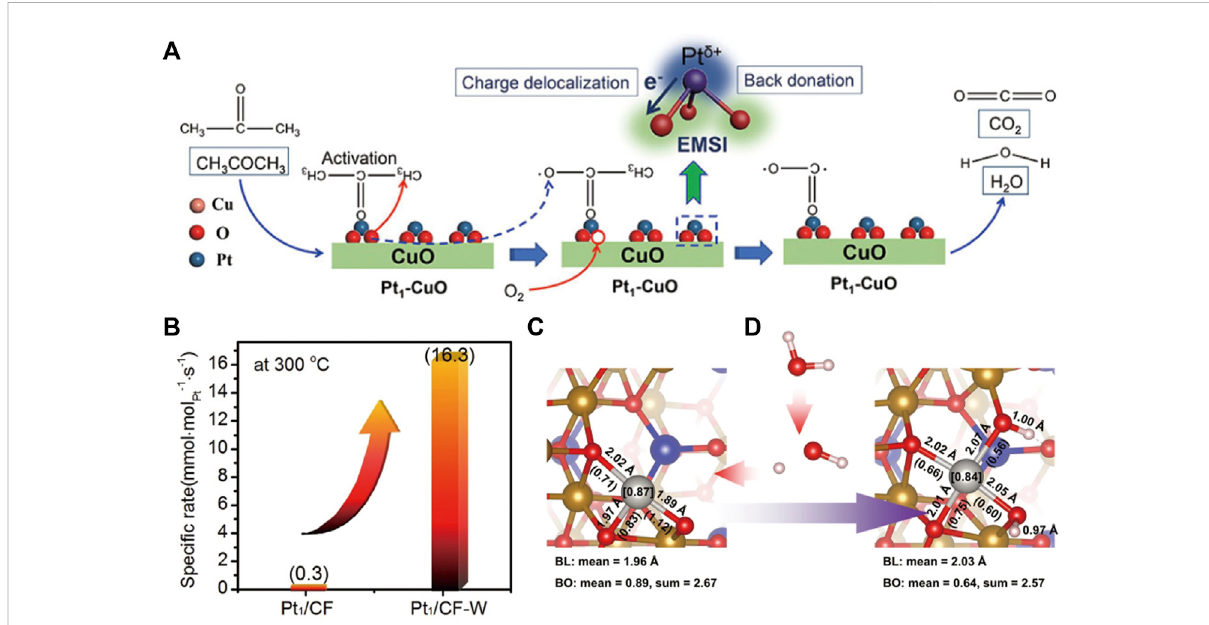
FIGURE 3 (A) Proposed catalytic mechanism of acetone oxidation over the EMSI-modulated Pt 1 -CuO catalyst. Reprinted from Jiang et al. (2022). Copyright © 2022,withpermissionfromWiley-VCHGmbH. (B) Speci fi crateofCH 4 conversiononPt 1 /CoFe 2 O 4 (Pt 1 /CF)andPt 1 /CoFe 2 O 4 afterwater treatment (Pt 1 /CF-W) at 300 ° C; The coordination structure of Pt 1 /CF (C) and Pt 1 /CF-W (D) . Reprinted from Yang Y. et al. (2022). Copyright © 2022, with permission from Springer